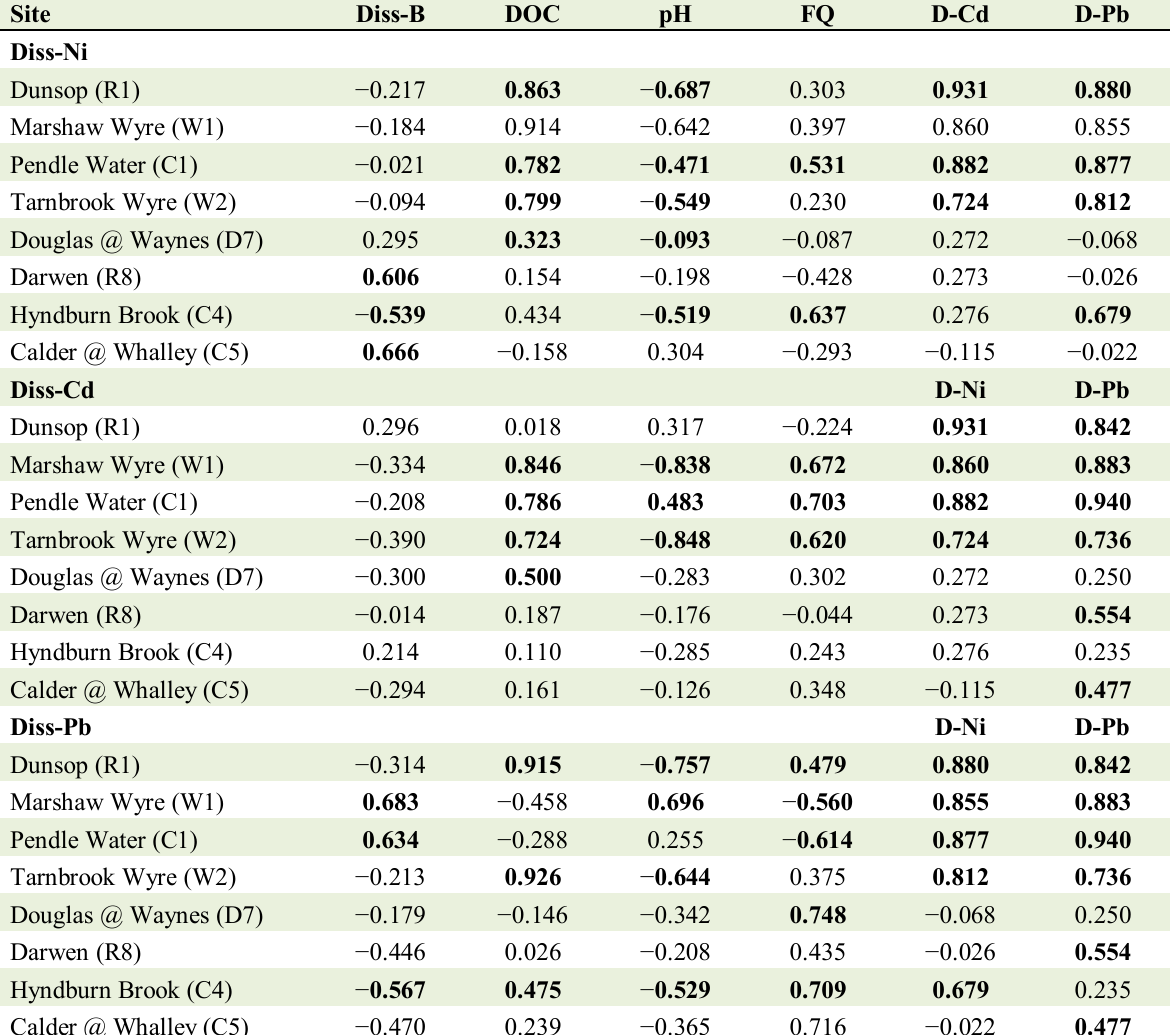
Table 3. Correlation coefficients for selected sites for ( a ) D-Ni; ( b ) D-Cd; and ( c ) D-Pb (n − 1 = 42; p < 0.001 in bold).